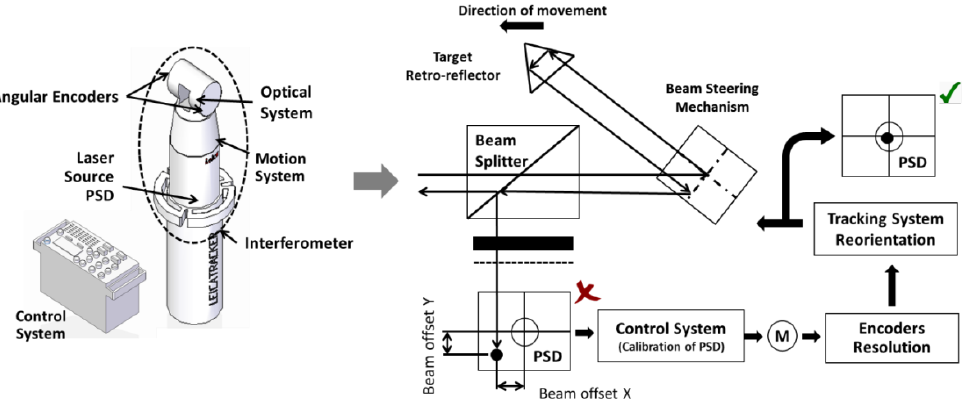
Figure 1. Errors due to encoders and sensor. Position-sensitive device (PSD).